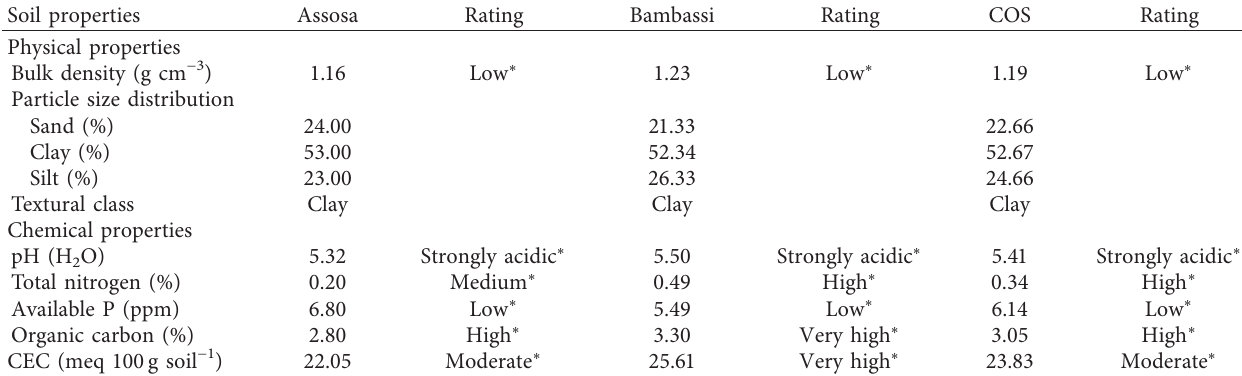
Table 1: Initial soil physicochemical properties of the experimental sites.